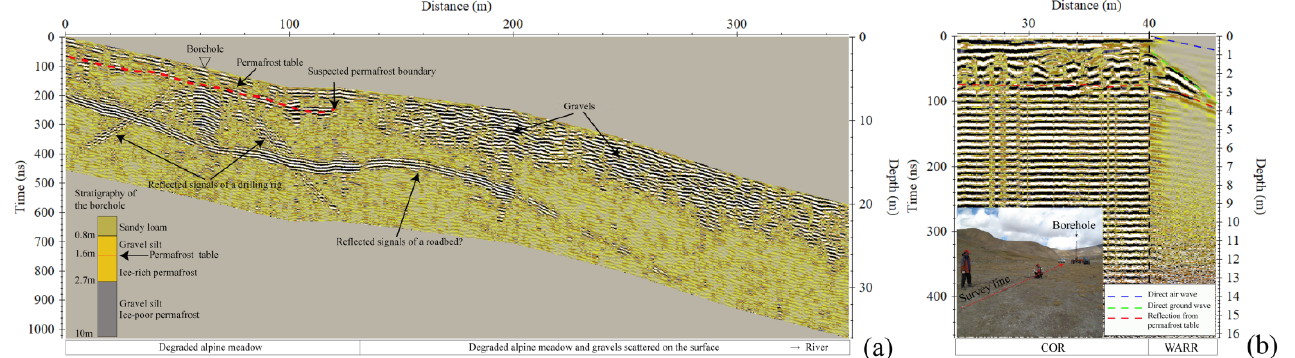
Figure 2. The ground-penetrating radar (GPR) profiles obtained using different antennas and methods. ( a ) A GPR profile obtained by RTA (P034, altitude: 4309–4286 m, antenna offset: 2.2 m, sampling